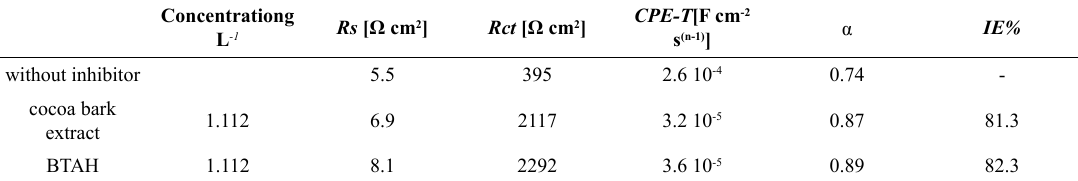
Table 2. Results for the parameters obtained from the fitting of the EIS diagrams presented in Figure 4 with the equivalent electrical circuit of Figure 5. Concentrationg L -1